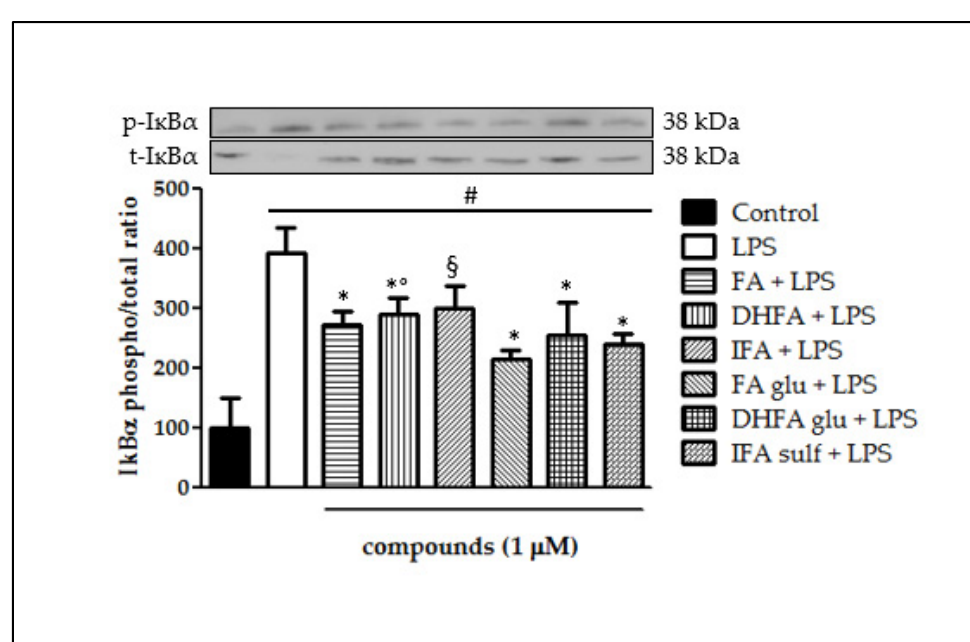
Figure 6. Degradation of I ĸ B α reported as percentage of the control phospho I ĸ B α /total I ĸ B α ratio in Caco ‐ 2 cells treated with LPS (1 μ g/mL) for 48 h and pretreated for 30 min with FA, DHFA, IFA, FA glu, DHFA glu, and IFA sulf (1 μ M) preceding LPS co ‐ exposure. Control and LPS groups were pretreated with an equivalent volume of methanol. Each column represents the mean ± SD of inde ‐ pendent experiments ( n = 6). Significant differences among groups are described using different superscript symbols; * = significant vs. LPS ( p < 0.001); # = significant vs. control ( p < 0.001); ° = significant vs. FA glu + LPS ( p < 0.05); § = significant vs. LPS and FA glu + LPS ( p < 0.01). Representa ‐ tive WB picture of the experiment is shown.